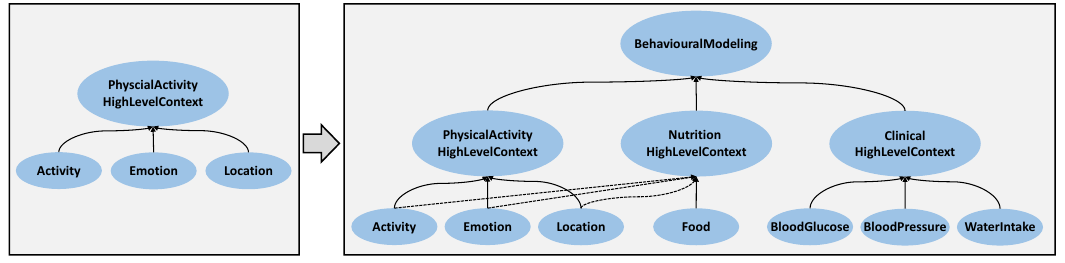
Figure 1. Extended Domains for Ontology evolution in